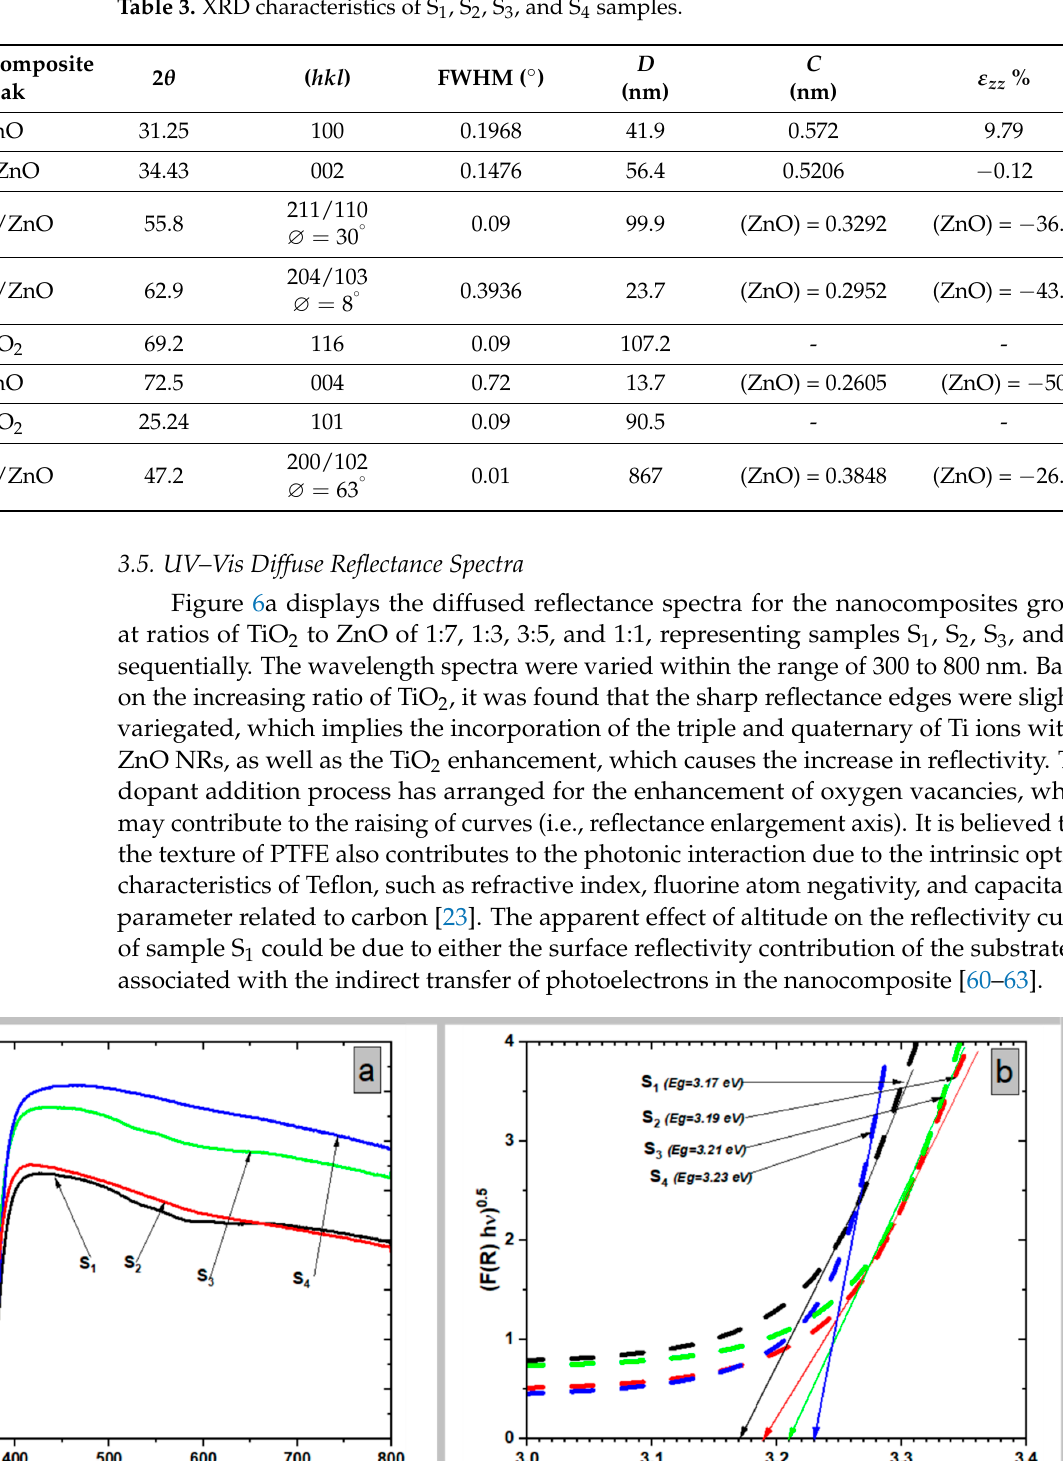
Table 3. XRD characteristics of S 1 , S 2 , S 3 , and S 4 samples.